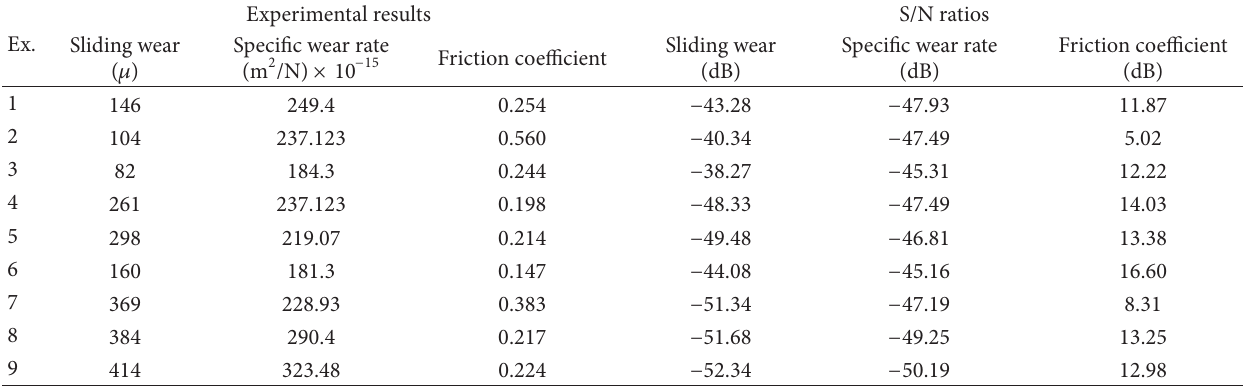
T 4: Experimental results of wear and friction coefficient and their S/N ratios.